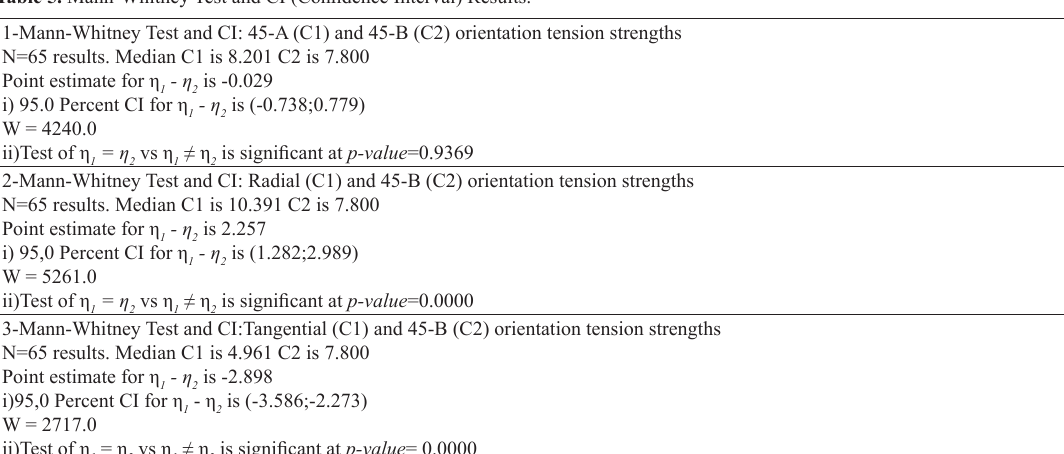
Figure 11. Plotting of the total results for Radial and Tangential Tension Table 5. Mann-Whitney Test and CI (Confidence Interval) Results.